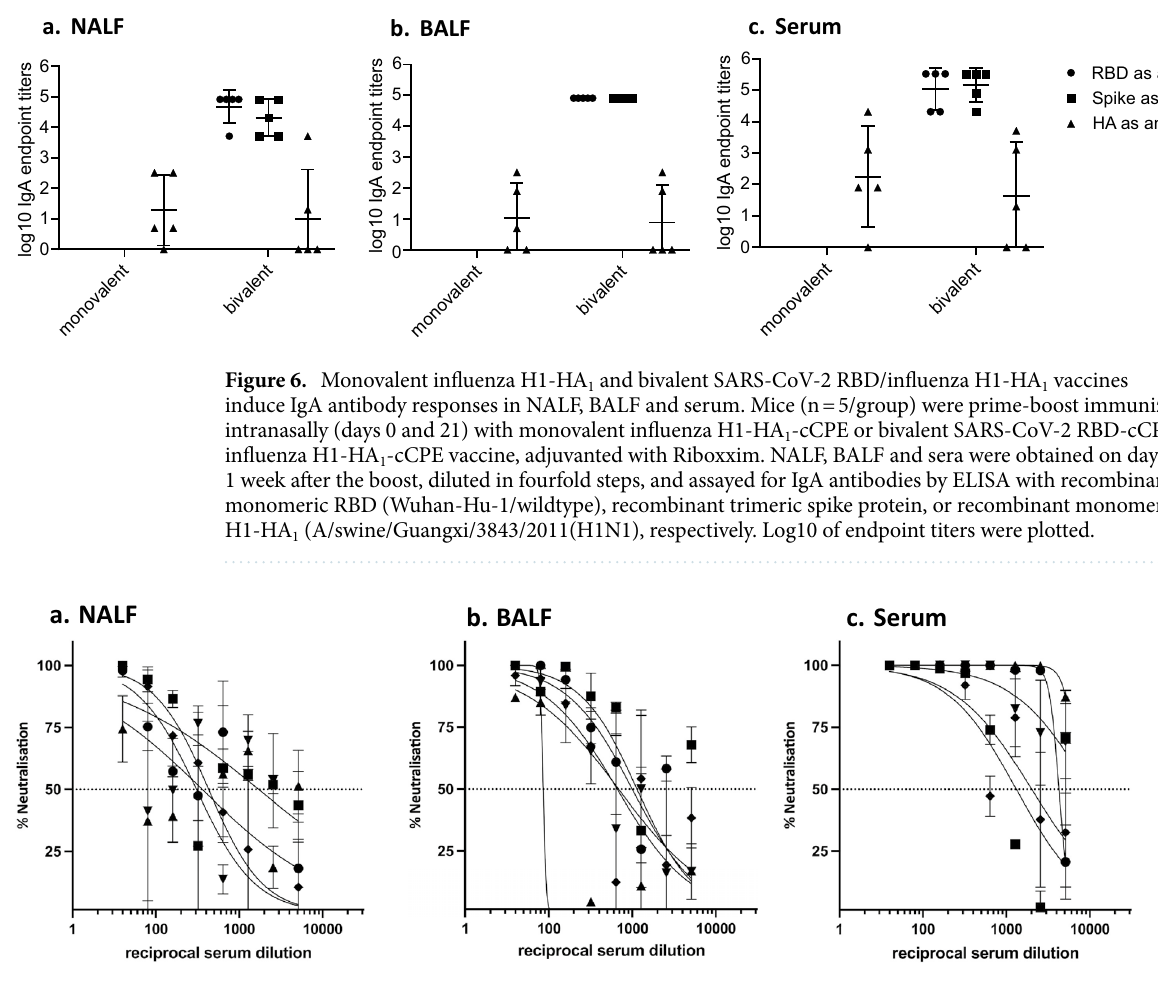
Figure 7. Bivalent SARS-CoV-2 RBD-cCPE/influenza H1-HA 1 -cCPE induces SARS-CoV-2 pseudovirus (Wuhan-Hu-1) neutralizing antibodies in NALF, BALF and serum. Mice (n = 5, a–e) were prime-boost immunized intranasally (days 0 and 21) with bivalent SARS-CoV-2 RBD-cCPE/influenza H1-HA 1 -cCPE vaccine, adjuvanted with Riboxxim. NALF, BALF and sera were obtained on day 28, 1 week after the boost, diluted in fourfold steps, and assayed for neutralization of SARS-CoV-2 pseudoviruses. The spike protein sequence was derived from SARS-CoV-2 strain